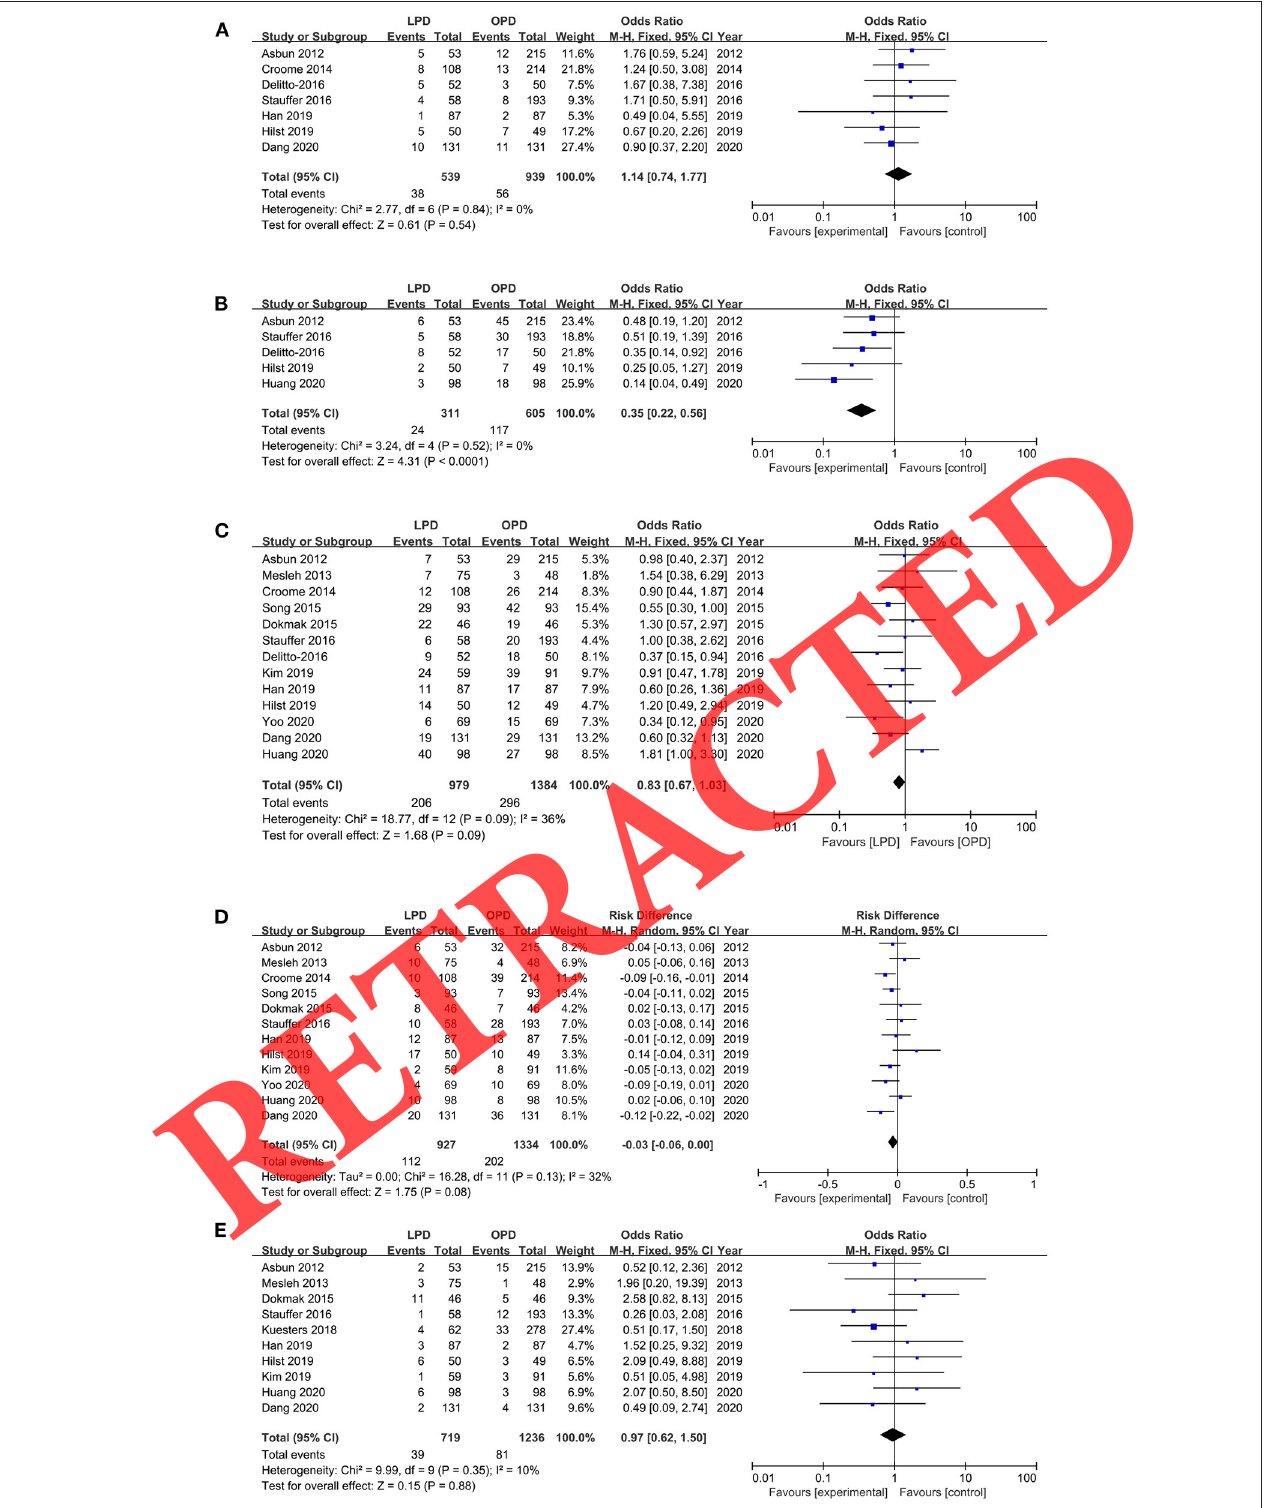
FIGURE 5 | Forest plot of comparison of LPD vs. OPD for overall complication rates. (A) Forest plot for postpancreatectomy hemorrhage; (B) forest plot for wound infection; (C) forest plot for postoperative pancreatic fistula; (D) forest plot for delayed gastric emptying; and (E) forest plot for reoperation.